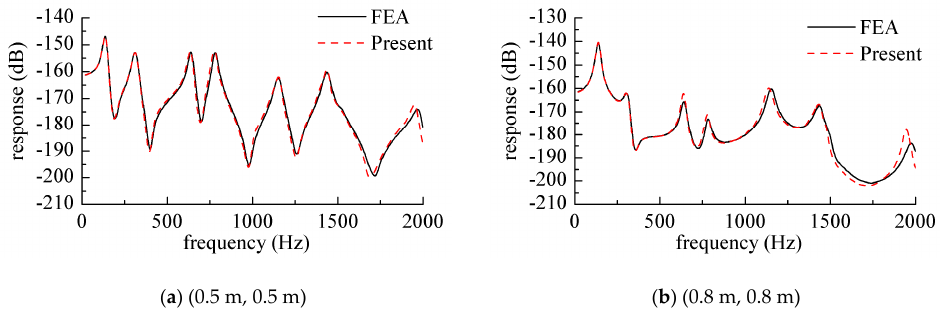
Figure 12. Response curve while the harmonic force acted on the center of the cantilever plate. ( a ) (0.5 m, 0.5 m), ( b ) (0.8 m, 0.8 m).